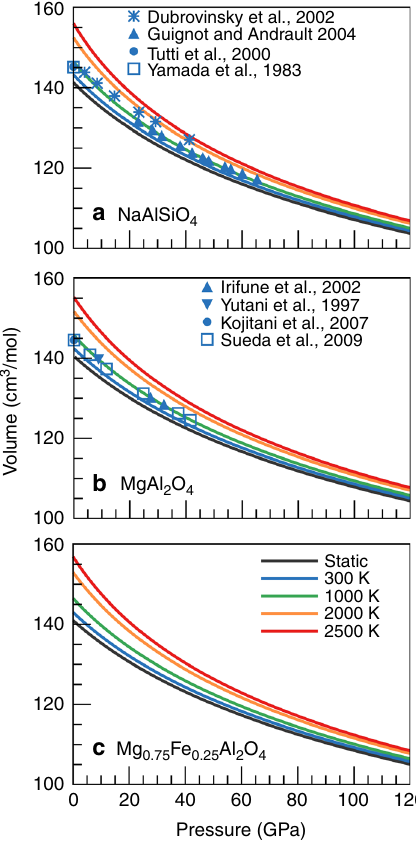
Fig. 1 Compression curves of CF-type phases. a NaAlSiO 4 , b MgAl 2 O 4 , and c Mg 0.75 Fe 0.25 Al 2 O 4 . Colorful lines represent ab initio results at variable temperatures and points are experimental data in previous studies 38 – 45